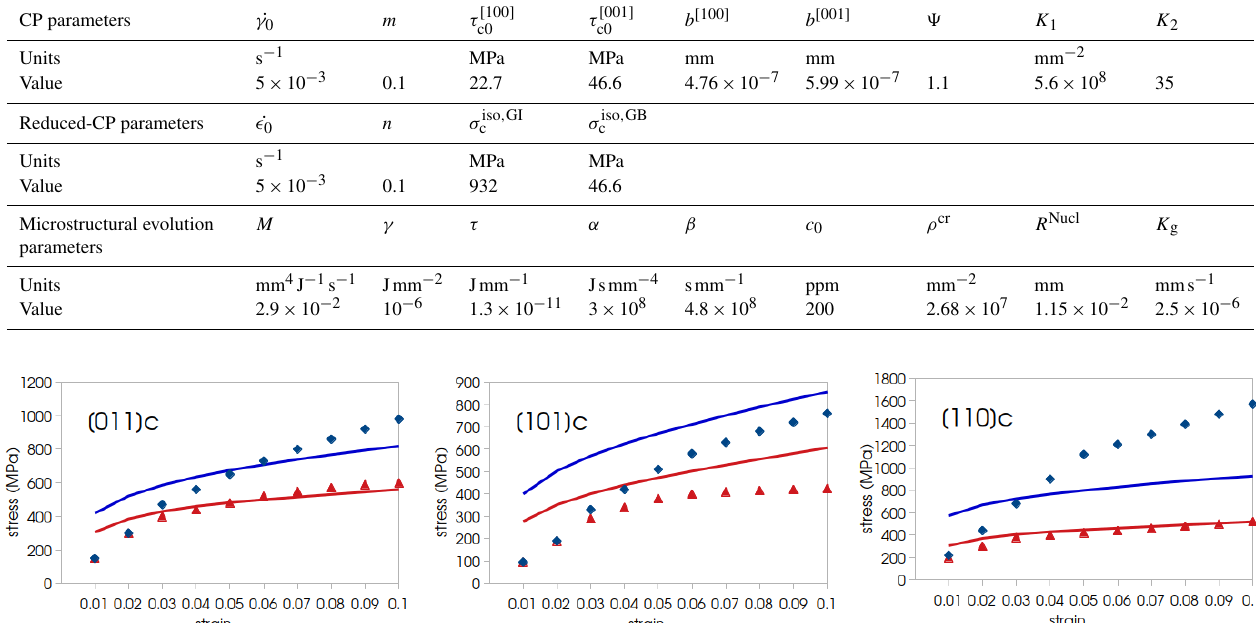
Table 2. Values of the different material parameters used in this work (temperature of 1573K and strain rate of 10 − 5 s − 1 ). CP parameters